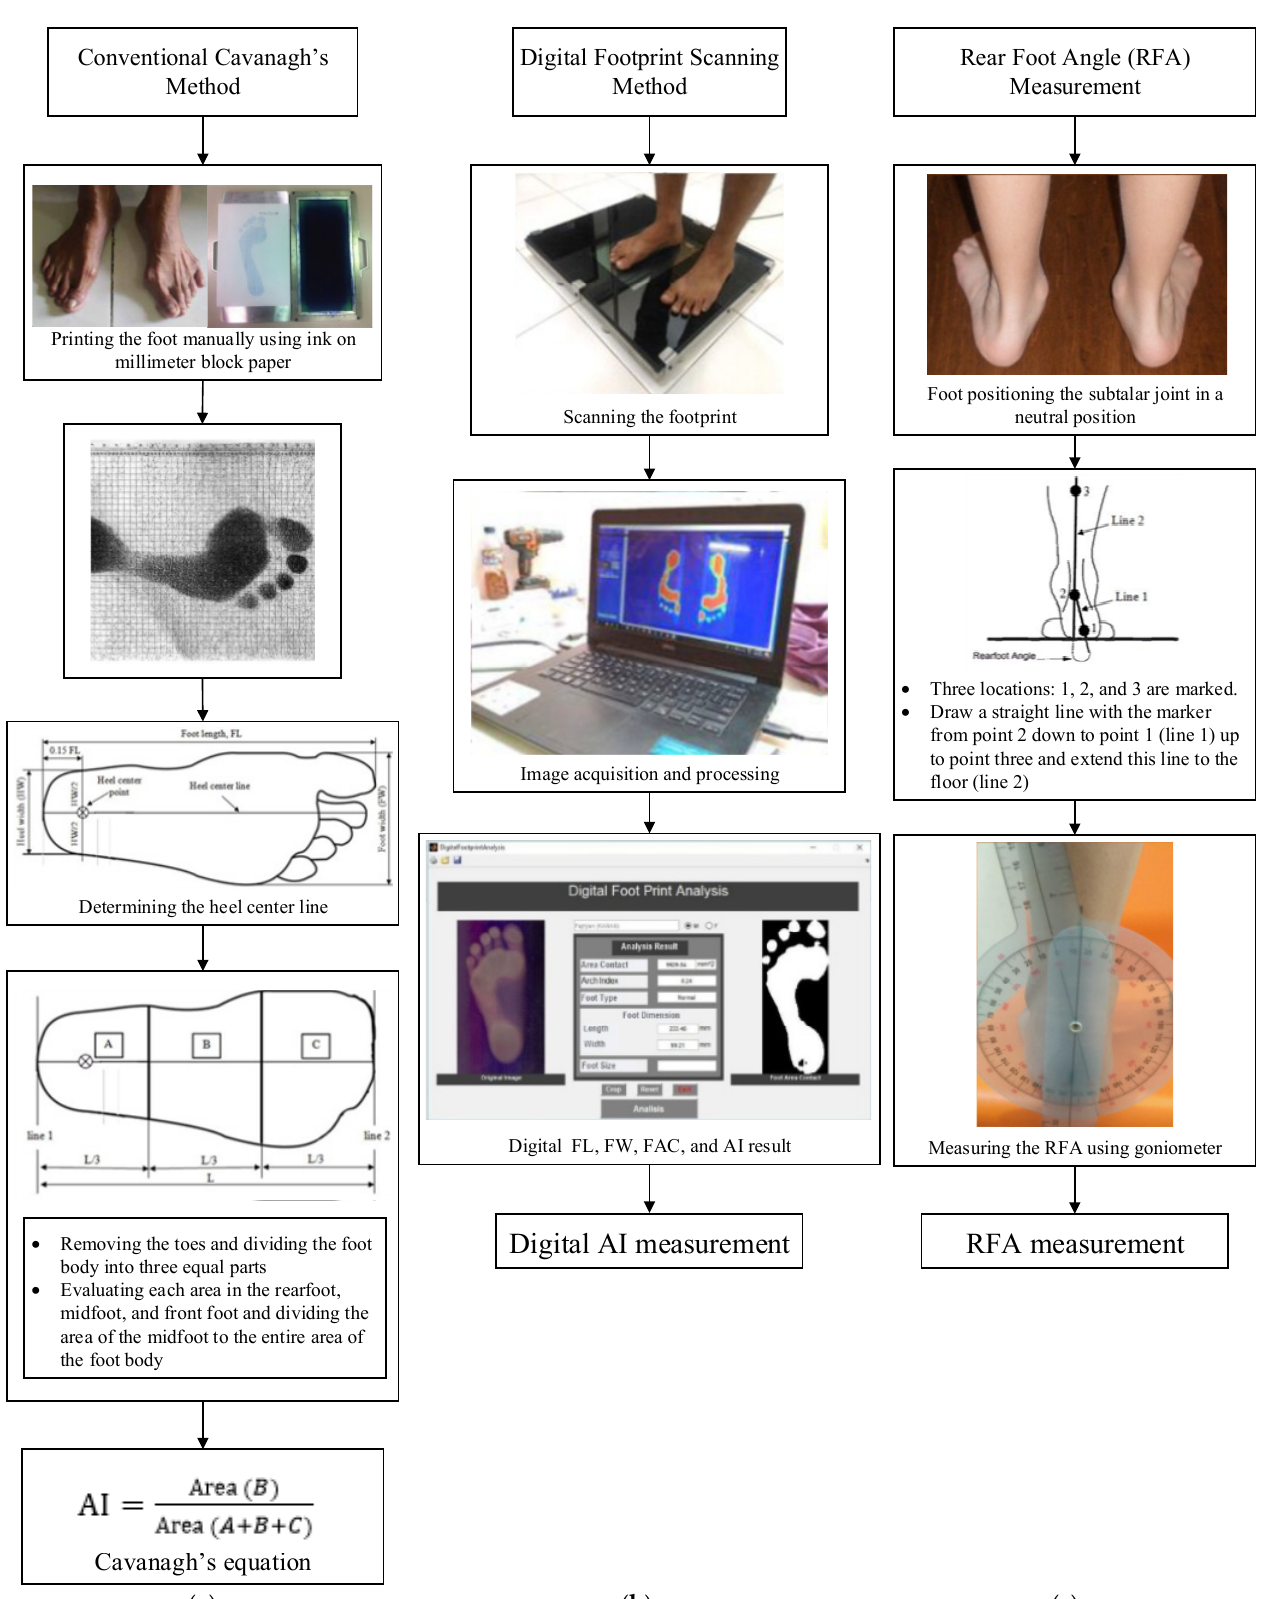
Figure 1. Comparison of flatfoot determination methods: ( a ) Cavanagh’s AI measurement method, ( b ) Digital AI measurement method, and ( c ) Rearfoot angle (RFA) measurement method.